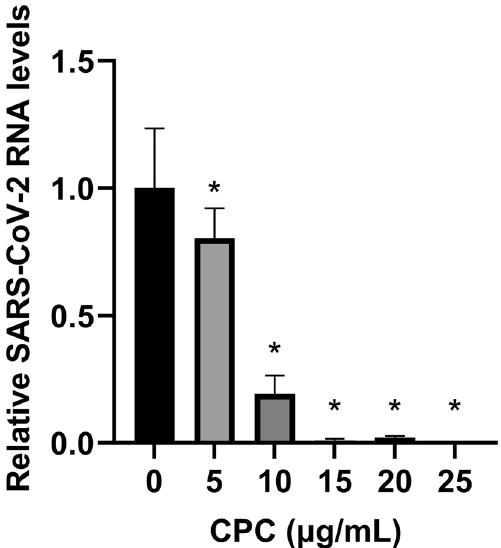
Figure 2. Antiviral efficacy of CPC against SARS-CoV-2 by qRT-PCR. VeroE6/TMPRSS2 cells were inoculated with SARS-CoV-2 Wuhan strain at a multiplicity of infection (MOI) of 0.01 after mixing equal amount CPC. At 24 h postinfection, the relative levels of viral N protein RNA were evaluated quantitatively by qRT-PCR. (* p < 0.05).